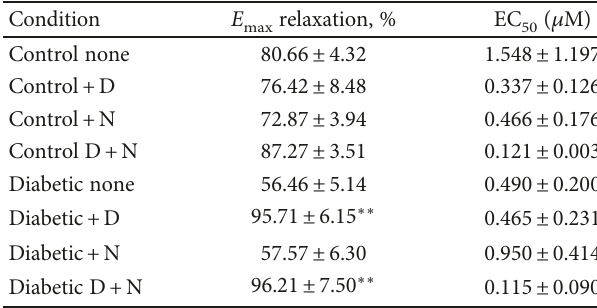
Table 4: E ff ects of a 30min incubation period with 50 μ M dantrolene (D), 50nM nimodipine (N), and both drugs in combination (D +N) on EC and E values for ACh-induced 50 max relaxation in control and diabetic